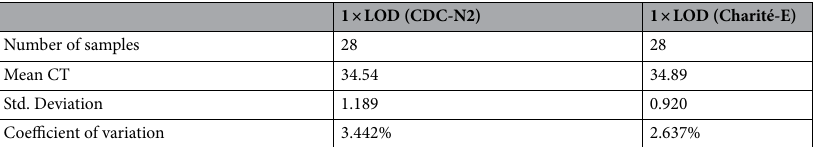
Table 4. Quantifying variability from heterogeneous saliva matrices on the performance of the UoNATS assay; 28 different saliva samples were spiked with reference standard at the LOD of 1 vc µL −1 to measure the effect of uncontrollable inhibitory factors on the accuracy of results.